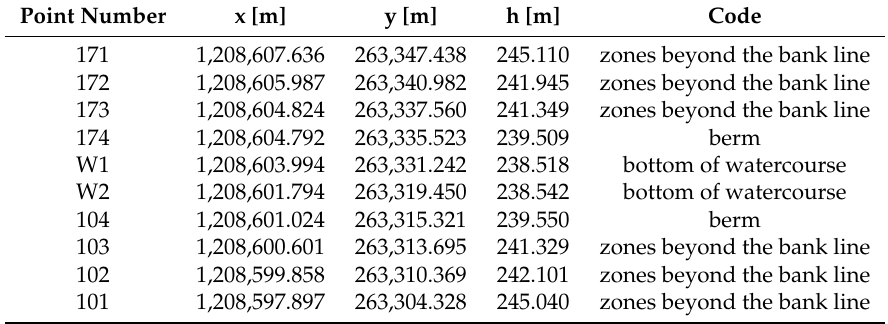
Table 2. A sample of processing of measured